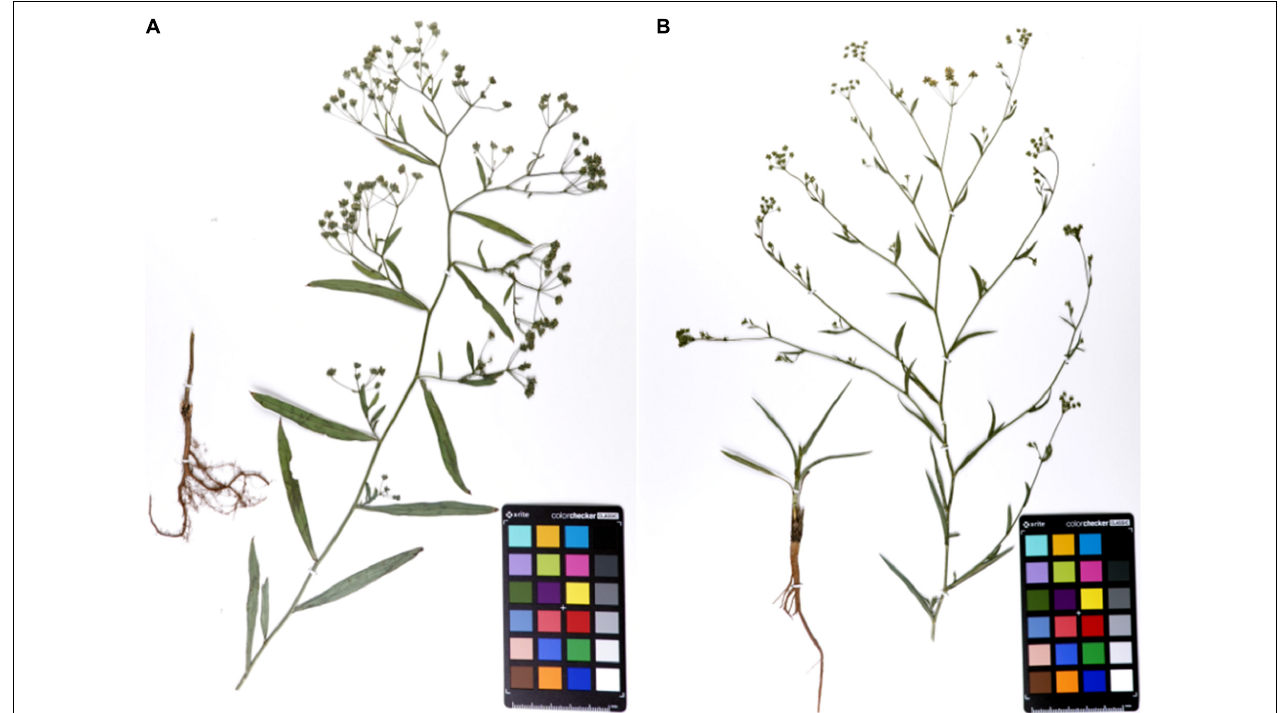
FIGURE 1 | The specimens of mature Bupleurum chinense DC. (A) and Bupleurum scorzonerifolium Willd. (B) .